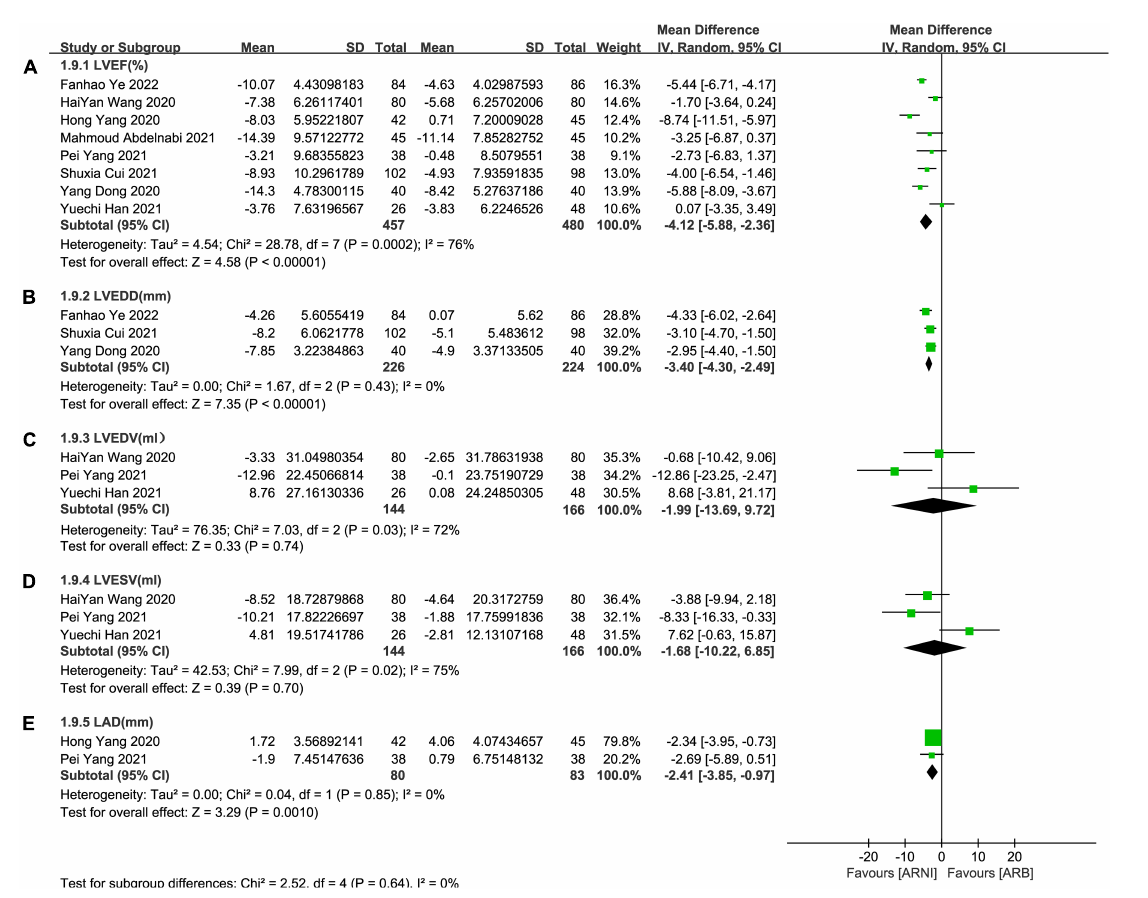
FIGURE5 Forest plots for the effect of ARNI on CRR indices in contrast with ARBs. (A) The forest plots of the left ventricular ejection fraction, (B) the forest plots of the left ventricular end-diastolic diameter, (C) the forest plots of the left ventricular end-diastolic volume, (D) the forest plots of the left ventricular end-systolic volume, and (E) the forest plots of the left atrial dimension.